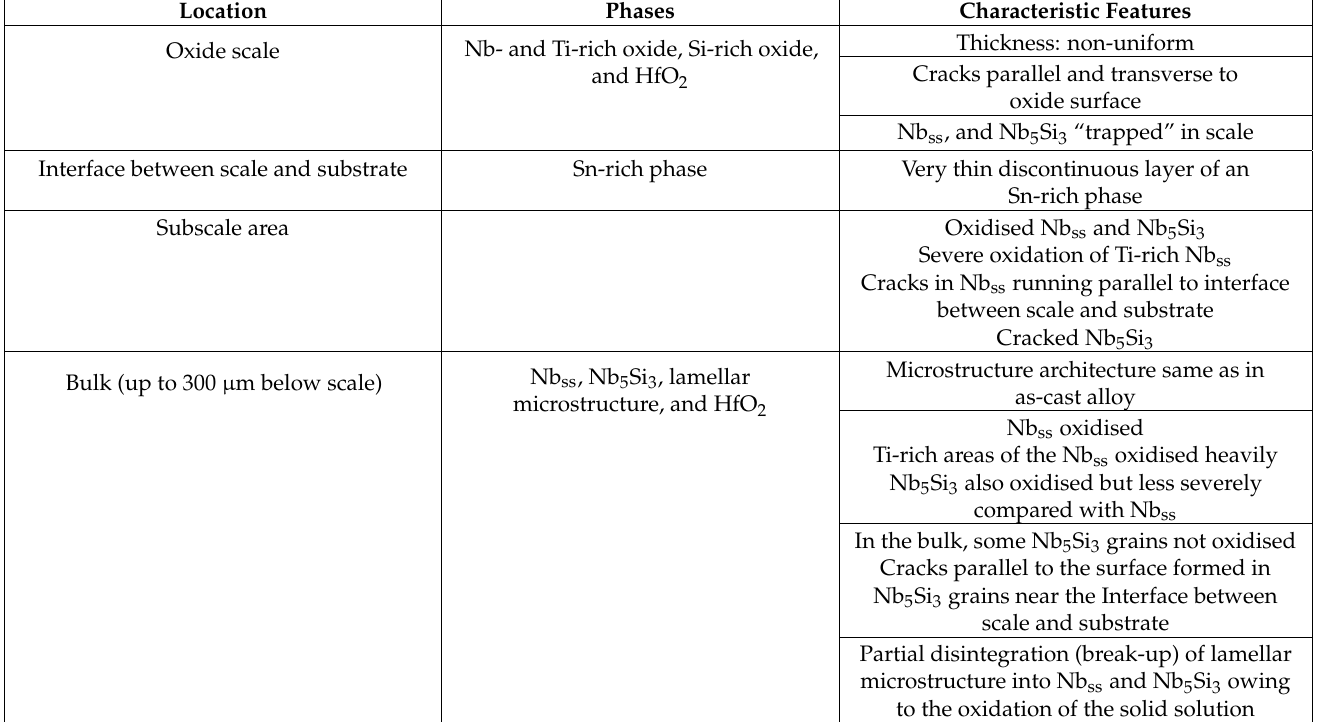
Table 6. Phases and characteristic features of the oxide scale and bulk of the oxidised alloy NV1 at 800 ◦ C/100